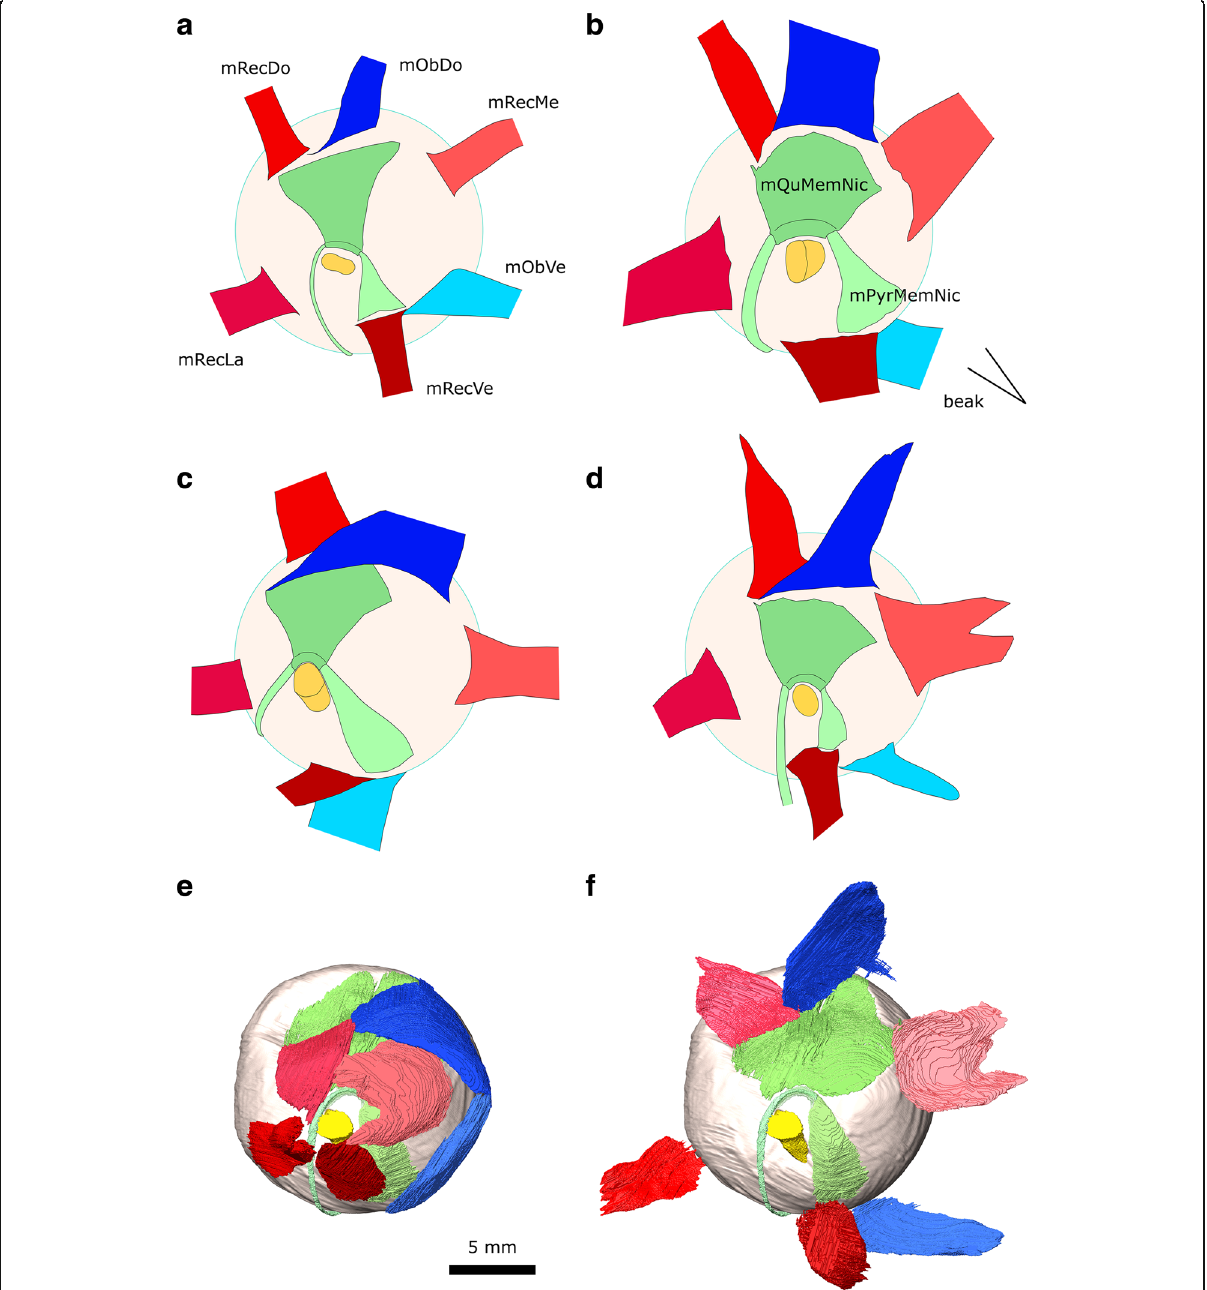
Fig. 16 Eye muscle arrangement in medial view of the left eye in a Passer domesticus , sparrow, (redrawn from Slonaker [99] and reversed for comparison) b Meleagris gallopavo , turkey (redrawn from Harvey et al. [108]) and reversed for comparison) c Eudromia elegans , elegant crested tinamou (redrawn from Elzanowski [115]) d Columba livia , the rock dove (redrawn from Chard and Gundlach [102]) f Columba livia digital dissection e Columba livia digital dissection with the rectus and obliquus muscles folded